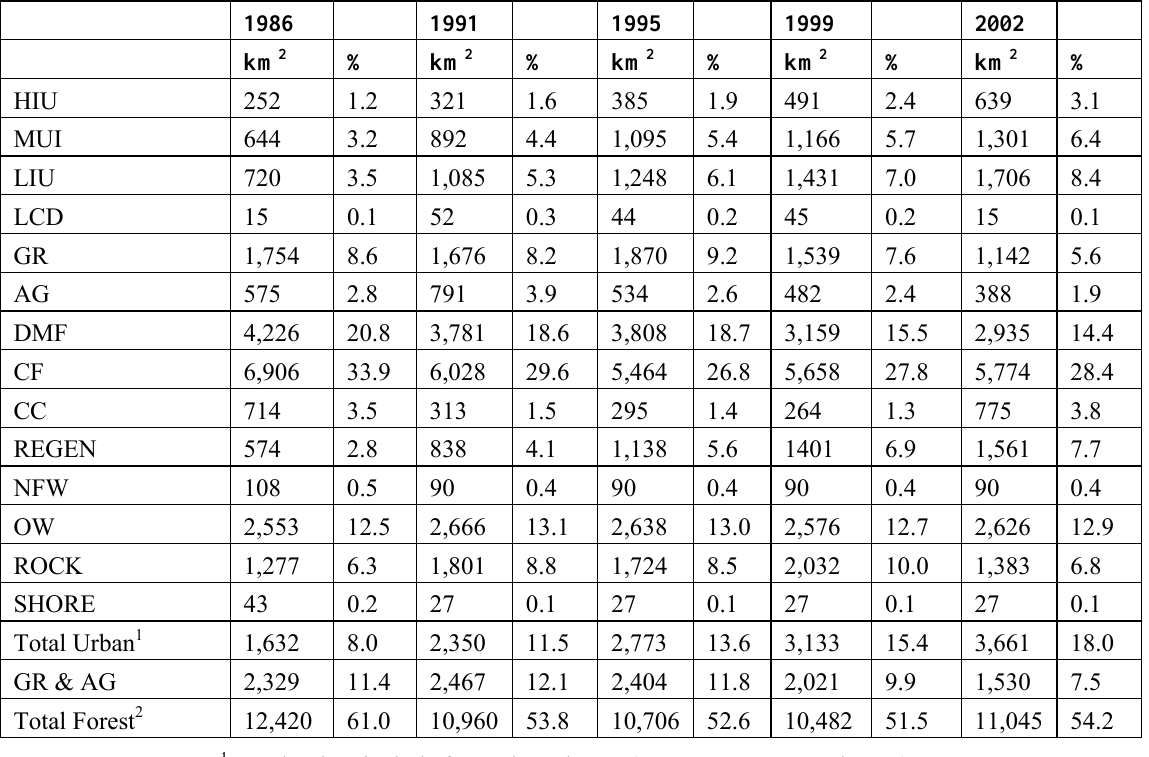
Table 3. Six county study area amount (km 2 ) and percent (%) of study area for each land cover class and three class groupings for 1986, 1991, 1995, 1999, and